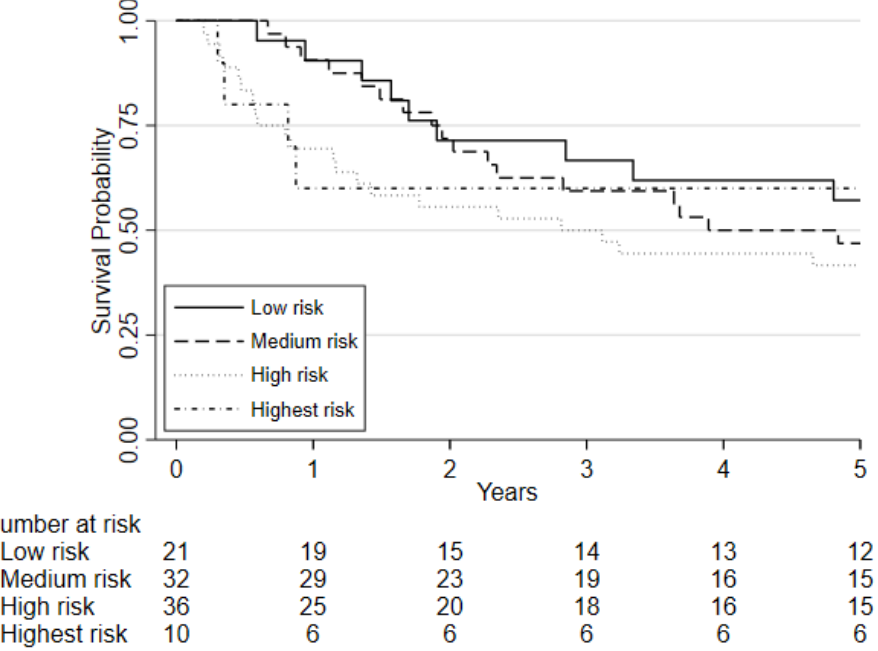
Figure 5. Kaplan-Meier plot of the estimated overall 5-year survival among patients with oesophago-gastric cancer who underwent CPET pre-and post-NAC/CRT followed by surgery, based on their pre-chemo/chemoradiotherapy (NAC/CRT) VO AT risk stratification category. Predefined risk stratification categories were defined as low risk VO VO at AT 11.0-14.0ml.kg -1 .min -1 , high-risk VO 2